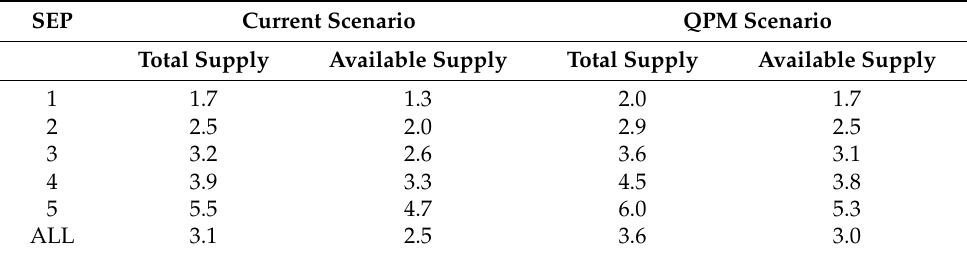
Table 3. The median total and available lysine supplies (g AME − 1 day − 1 ) by household socioeco- nomic position, including under a scenario with universal adoption of quality protein maize (QPM).